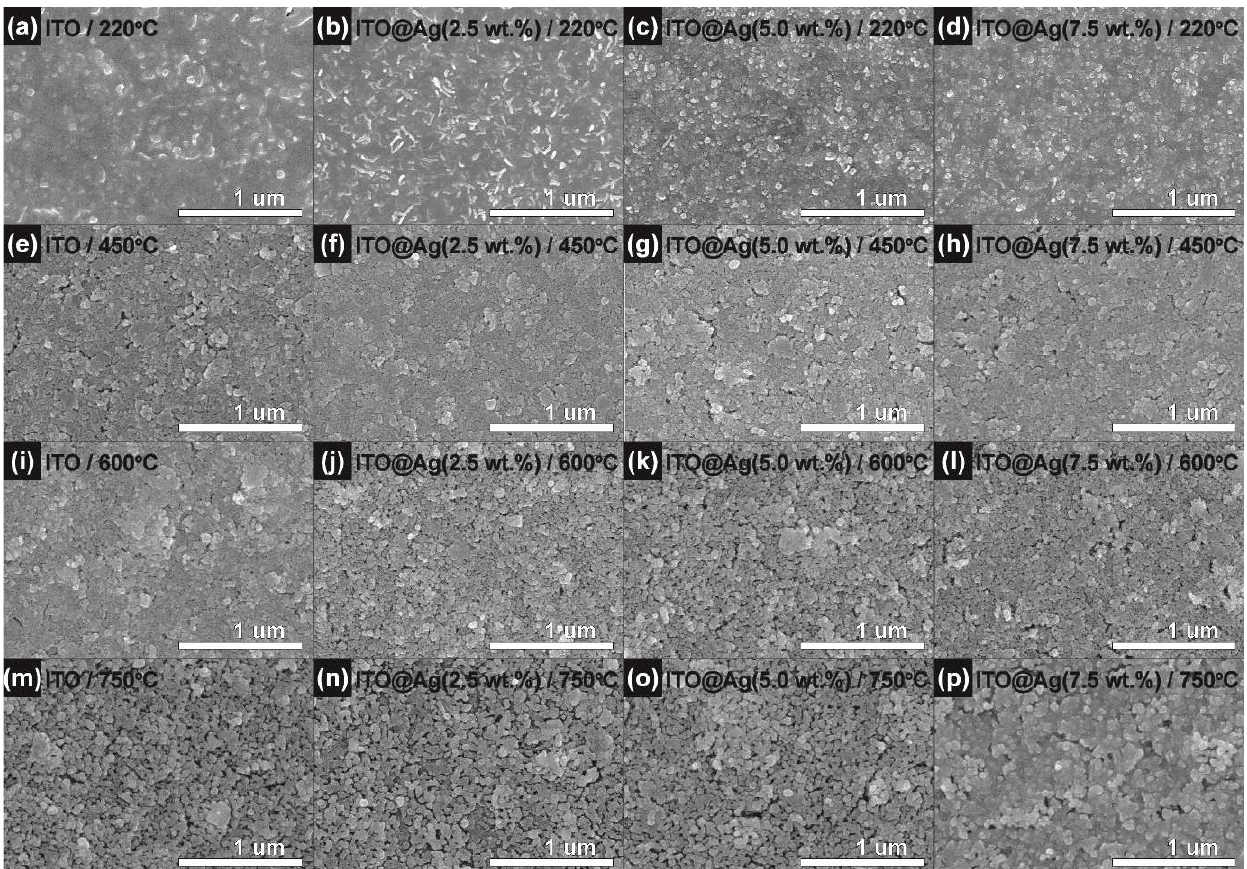
Figure 3. Scanning electron microscopy (SEM) images of the ITO and ITO@Ag thin films heat-treated at ( a−d ) 220, ( e−h ) 450, ( i−l ) 600, and ( m−p ) 750 °C according to the weight percentage of silver.